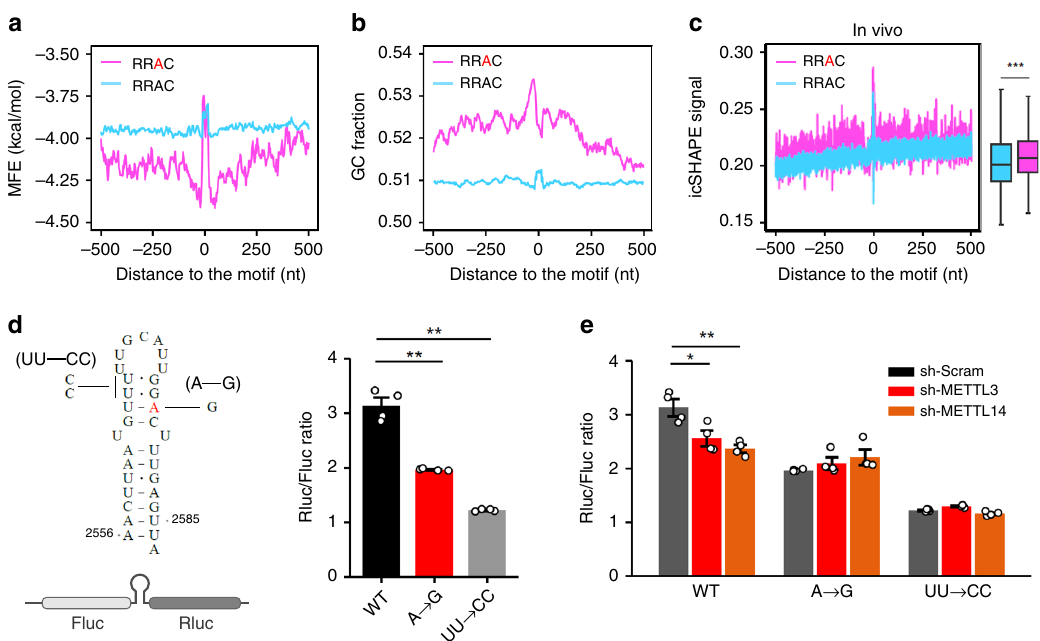
Fig. 3 CDS m 6 A methylation resolves mRNA secondary structures. a The predicted minimum folding free energy (MFE) is plotted along mRNA regions surrounding the CDS RRAC motif with (pink line) or without (blue line) m 6 A modi fi cation. A sliding window with 30 nt in length and a step of 3 nt was used to calculate MFE. For each window, the central position is used for alignment. A minus position value indicates upstream of m 6 A sites, whereas a positive value indicates downstream of m 6 A sites. The m 6 A site in RRAC motif is highlighted by red. Notably, a lower MFE value indicates a higher potential for RNA secondary structures. b The GC content is plotted along mRNA regions surrounding the CDS RRAC motif with (pink line) or without (blue line) m 6 A modi fi cation. c The in vivo icSHAPE signal is plotted along mRNA regions surrounding the CDS RRAC motif with (pink) or without (blue) m 6 A modi fi cation. Notably, a higher in vivo icSHAPE signal indicates a less structured region. The right boxplot shows the average of icSHAPE signals across mRNA regions from – 500 nt to 500 nt relative to the RRAC motif with (pink) or without (blue) m 6 A modi fi cation (Wilcox test, *** P < 0.001). The median of icSHAPE signals in each group is indicated by a center line, the box shows the upper and lower quantiles, whiskers shows the 1.5× interquartile range. The outliers are not shown. d The left panel shows the schematic of a dual luciferase reporter with a sandwiched secondary structure derived from MALAT1 (2556 – 2587). Both UU → CC and A → G mutants are also shown. The m 6 A site is highlighted by red. The right panel shows the ratio of Rluc/Fluc in transfected cells expressing wild type or indicated mutants. Error bars, mean ± s.e.m.; Single-tailed t test, n = 4, * P < 0.05, ** P < 0.01. e The ratio of Rluc/ Fluc in transfected cells expressing wild type or mutant reporters, with either METTL3 or METTL14 knockdown. Error bars, mean ± s.e.m.; single-tailed t test, n = 4, * P < 0.05, ** P < 0.01. Source data are provided as a Source Data fi